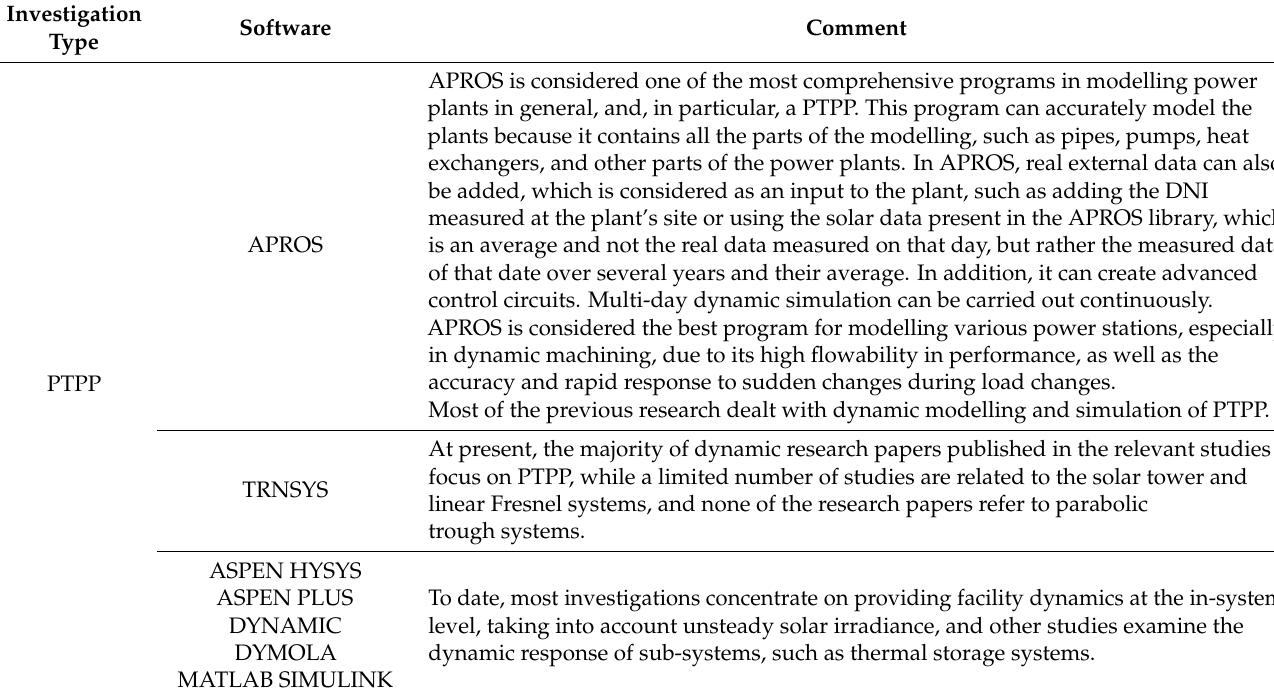
Table 2. Simulation programs